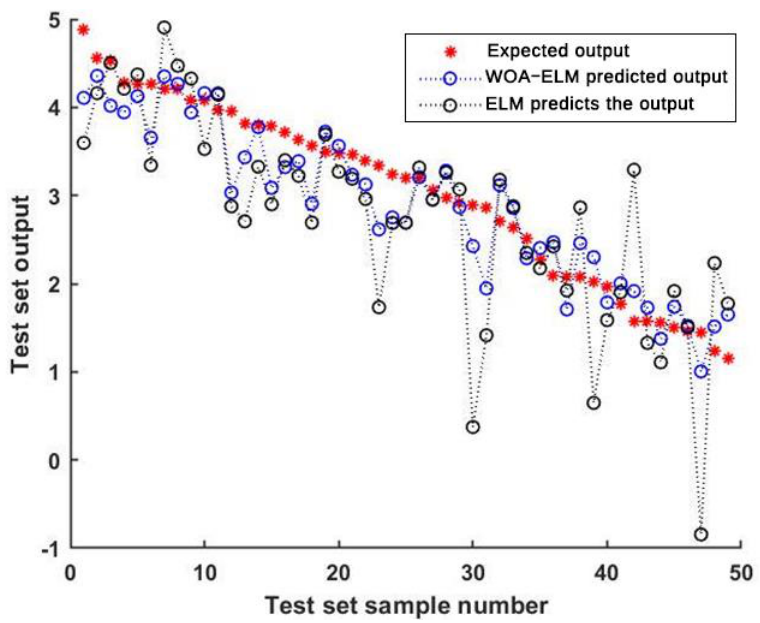
Figure 5. Inverse modeling of nitrogen content of rice.